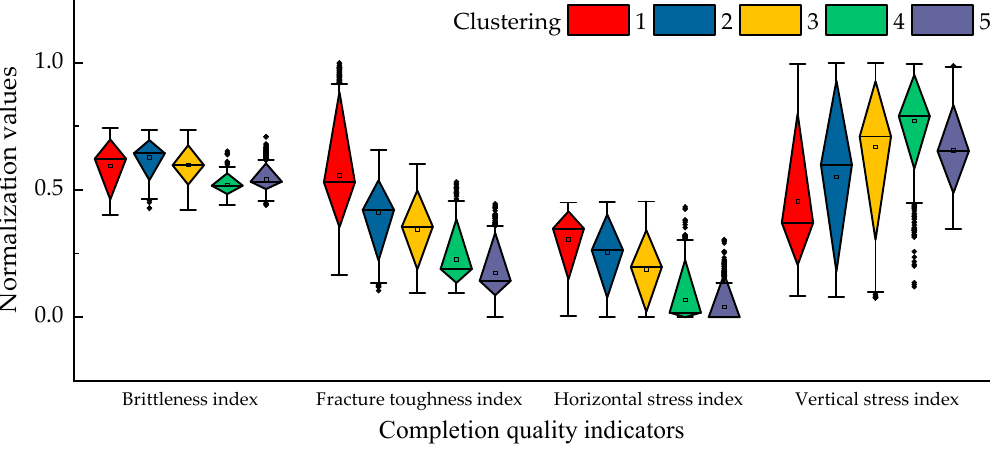
Figure 6. Boxplot of the completion quality evaluation index for well A.